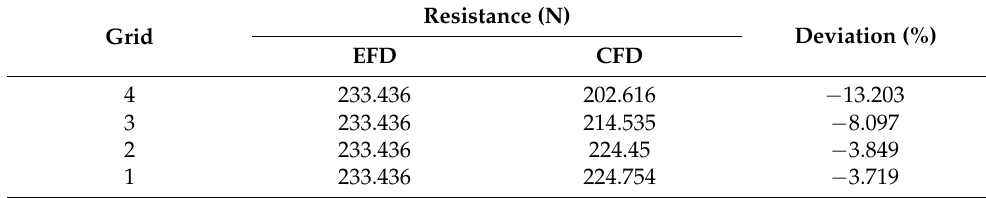
Table 4. Resistance comparisons of the test (EFD) and numerical (CFD) results for different grids.